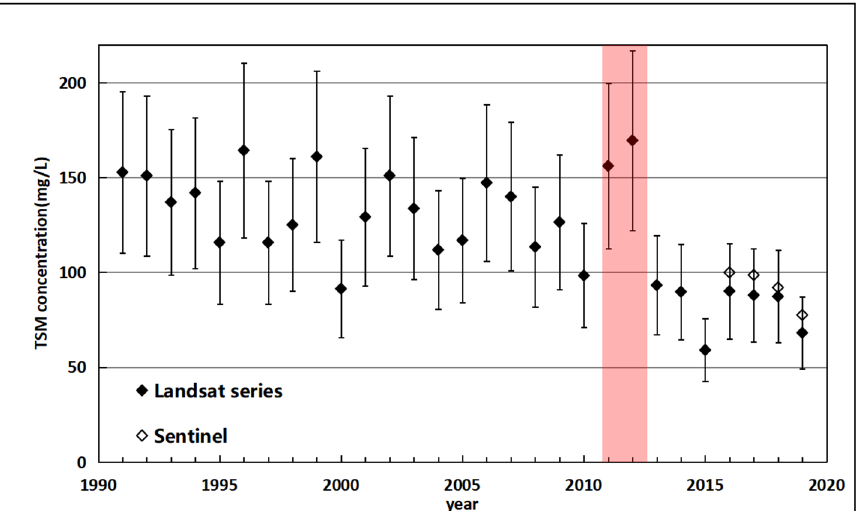
Figure 7. Changes in C TSM in the Padma River in the period 1991–2019, and the red area represents the duration of La Niña.